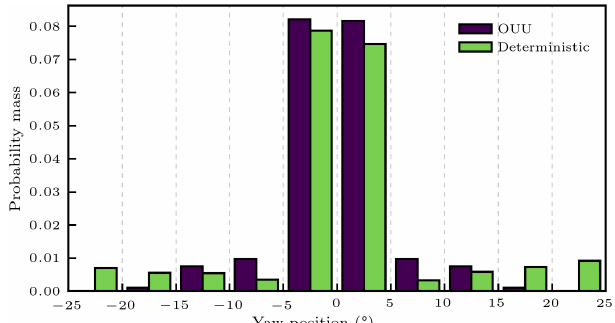
Figure 11. Probability mass distributions of y summed over all tur- bines, wind speeds, and wind directions in the 11-turbine wind plant test case, as prescribed by the OUU and deterministic wind plant optimization